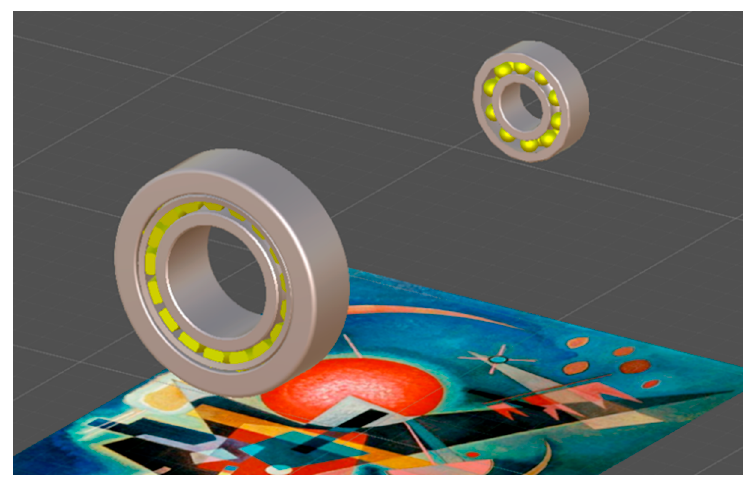
Figure 8. Display of two bearings in the Unity environment.